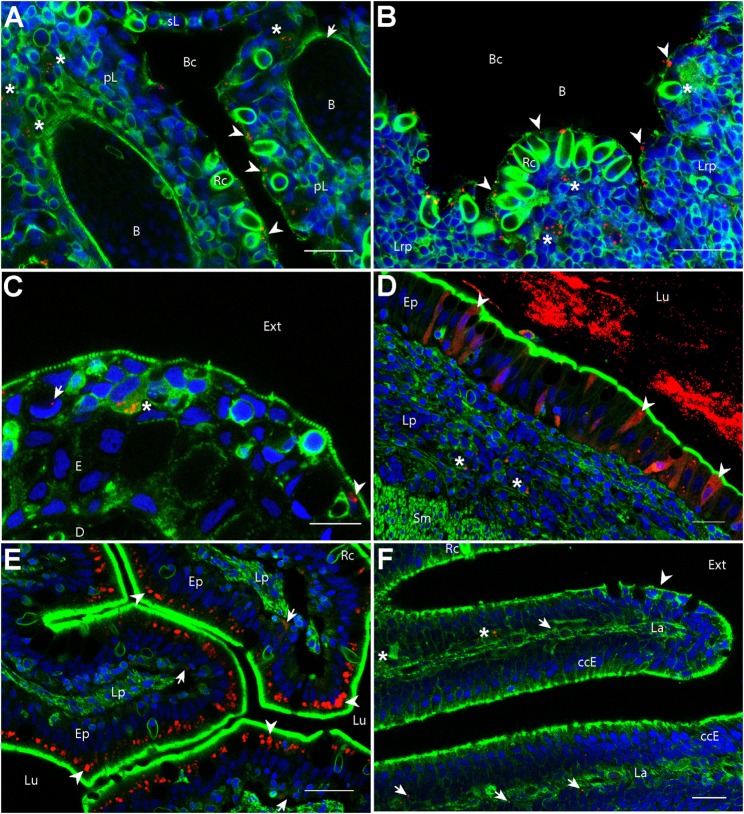
Biodistribution of poly(lactic acid) nanoparticles (PLA-NPs) in mucosae and thymus. Representative confocal images of gills (A), thymus (B), skin (C), intestines (D,E), and the olfactory mucosa (F), of wild-type adults immersed for 24 h in 0.01% red fluorescent nanoparticles (NPs). Images were acquired in 40-μm-thick whole-body cryosections, stained with phalloidin (green) and DAPI (blue). (A) In gills, NPs are found in pavement cells lining the branchial cavity (arrowheads), accumulated in cells located in the sub-epithelial compartment (stars), and detected in the blood (arrow). (B) NPs are located in pavement cells lining the branchial cavity above the thymus (arrowheads) and accumulated in cells of the lympho-reticular parenchyma in the thymus (stars). (C) In skin, NPs are visible in keratinocytes (arrowhead), goblet cells (characterized by kidney-shaped nucleus, arrow) and accumulated in intra-epithelial cells (star). (D,E) In the intestine, a high number of NPs is found inside the intestinal lumen
(D). As illustrated in the end-gut (D), NPs are taken up by enterocytes (arrowheads), which display a diffuse signal. A number of NPs is also observed in sub-epithelial cells (stars). In the post-midgut (E), NPs are mainly found in apical areas of specialized enterocytes (arrowheads); a subset is also found at the basal epithelial side (arrows). (F) In the nasal mucosa, NP-positive cells are found in the olfactory epithelium (arrowhead) and the lamina (arrows). NPs are accumulated in large cells of the lamina (stars). B, blood vessels; pL, primary lamellae; sL, secondary lamellae; Bc, branchial cavity; Rc, rodlet cells; E, epidermis; D, dermis; Ext, external environment; Lu, Lumen; Ep, epithelium; Lp, lamina propria; Sm, smooth muscles; Lrp, lympho-reticular parenchyma; La, lamina. Scale bar: 10 μm (B,E), 20 μm (A,C,F), and 30 μm (D).